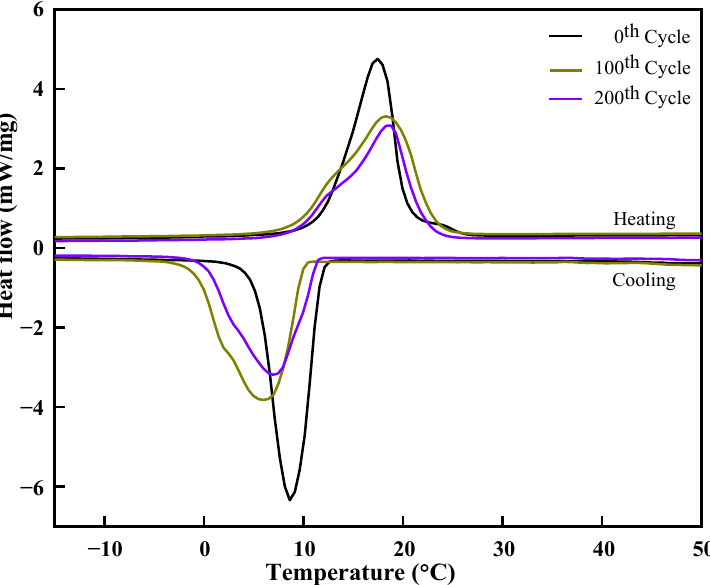
Figure 10. DSC thermographs of the eutectic PCM for 0th, 100th, and 200th thermal cycles. Table 3. Relative percentage difference of thermophysical properties after thermal cycling. No.